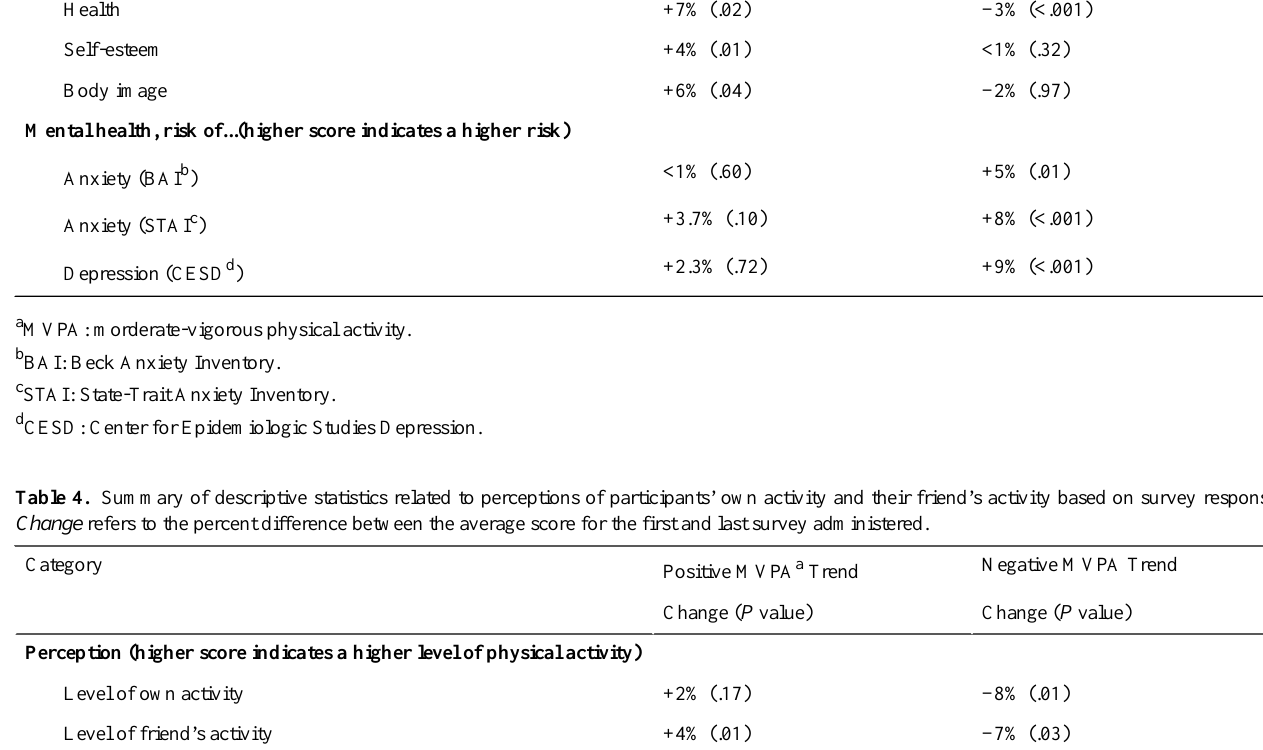
Self-image (higher score indicates a more positive perception)